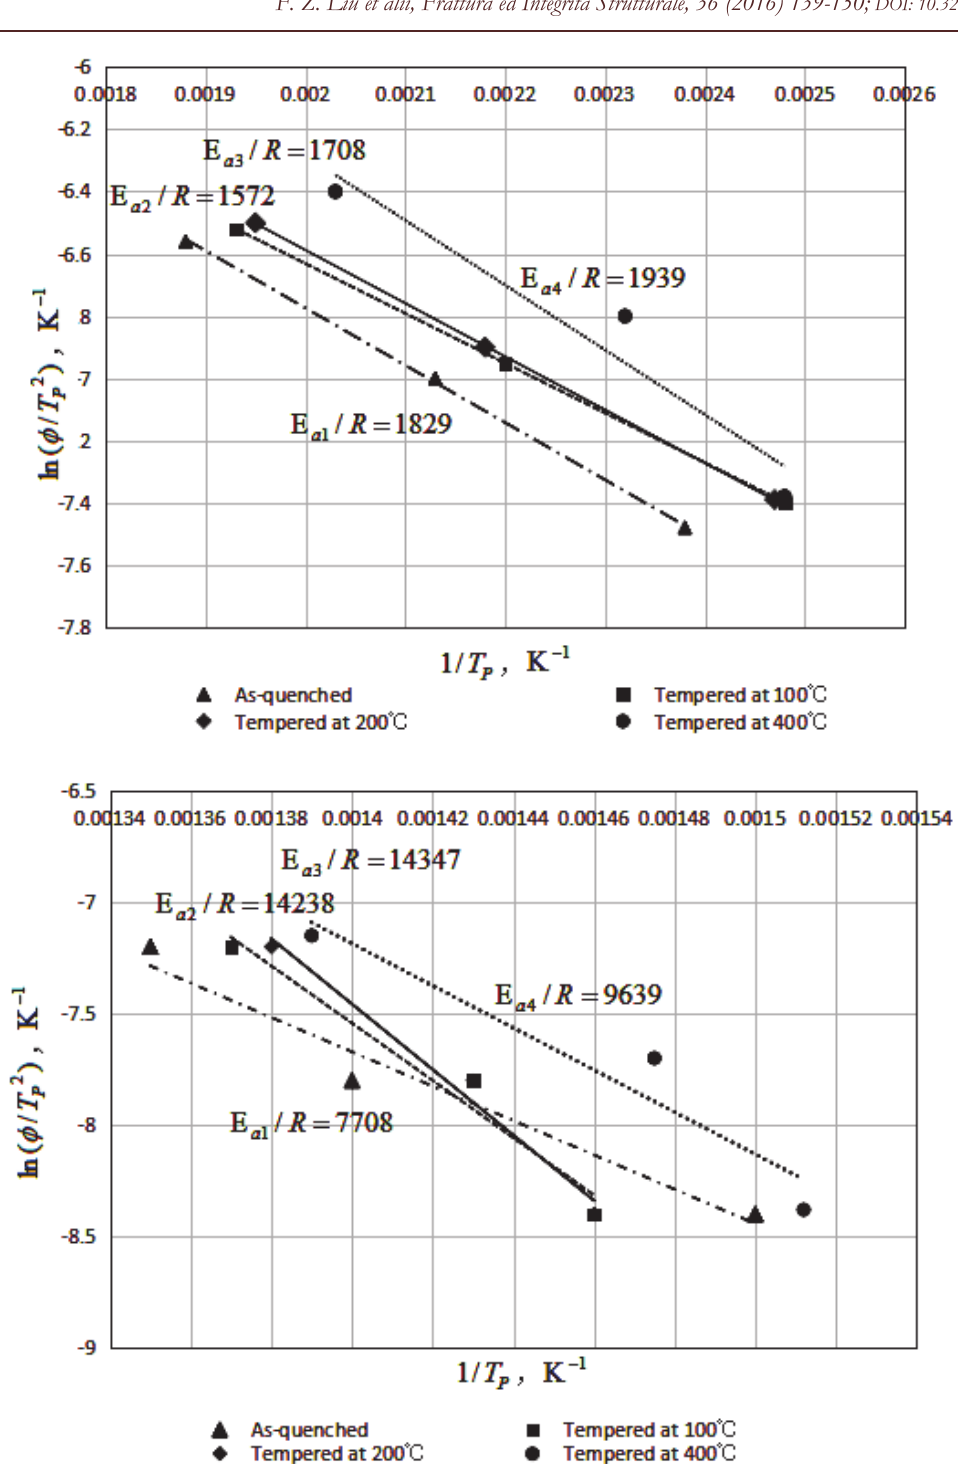
T of experimental materials: a) diffusible hydrogen; b) non-diffusible P